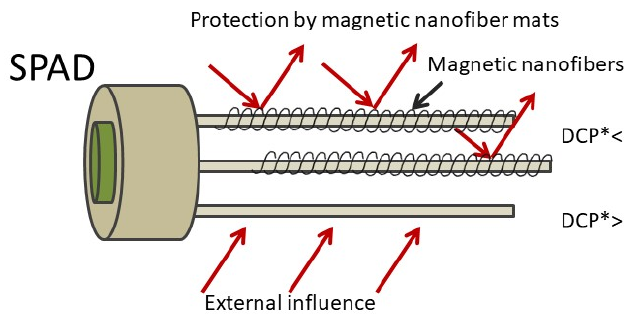
Figure 2. Schematic illustration of the novel single-photon avalanche diode (SPAD) design and the potential use of magnetic nanofiber mats to reduce external influences. The abbreviation (DCP*) means dark current pulses.